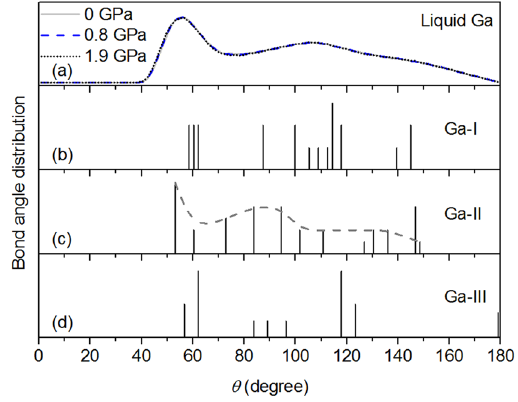
Figure 4. The bond angle distribution in ( a ) liquid gallium, ( b ) Ga phase I, ( c ) Ga phase II and ( d ) Ga phase III. The gray dashed curve is the profile from connecting all the peaks of bond angle distribution in Ga phase